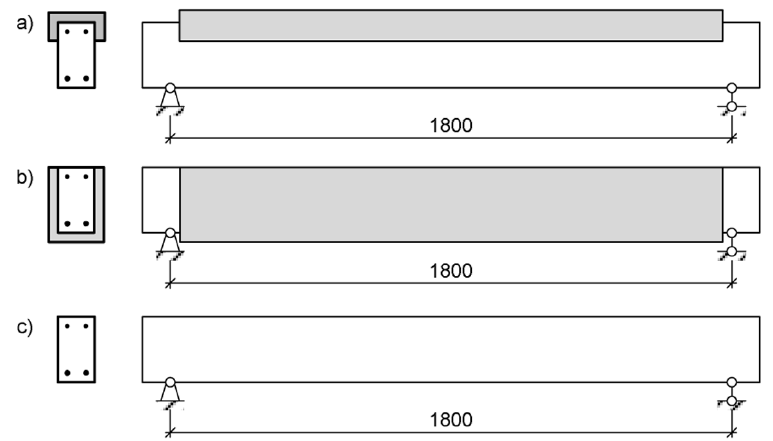
good as that achieved by treatment with a high-pressure water jet. The views of treated surfaces are presented in Figure 2.